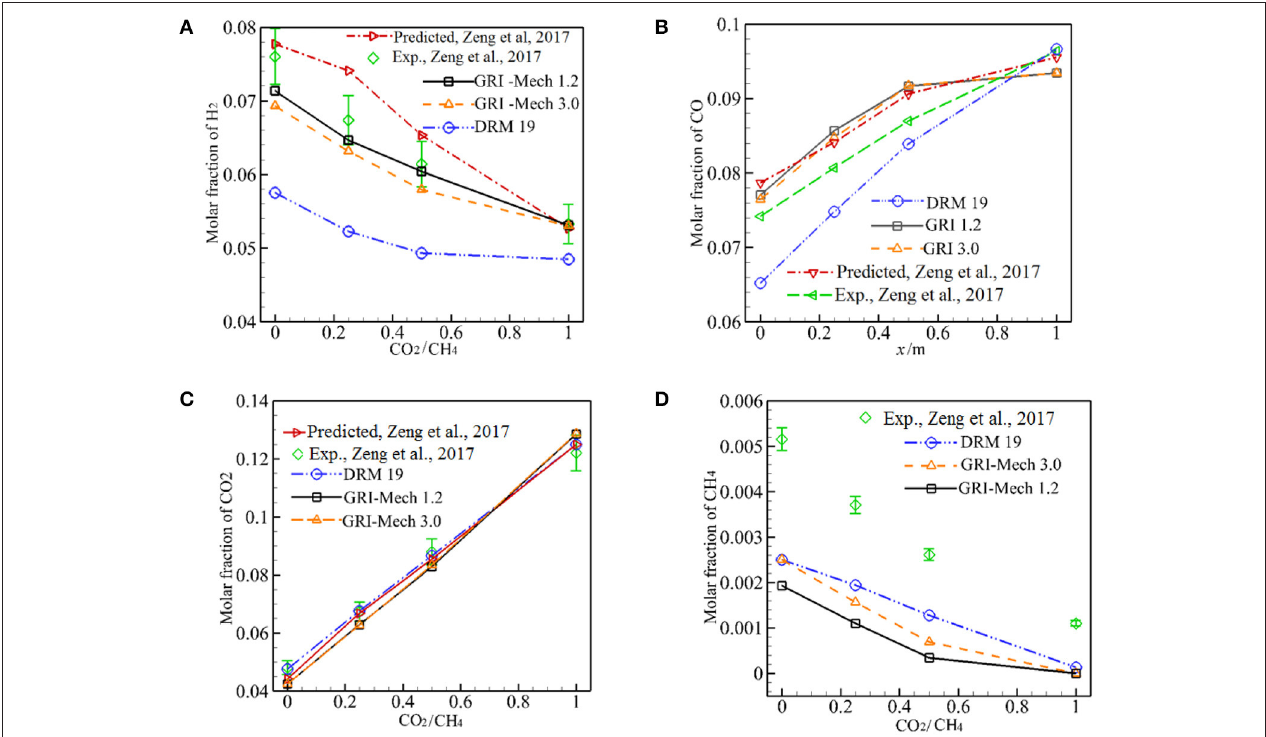
FIGURE 5 | Predicted molar fraction of H 2 , CO, CO 2 , and CH 4 by three different kinetics. (A) Molar fraction of H 2 ; (B) Molar fraction of CO; (C) Molar fraction of CO 2 ; (D) Molar fraction of CH 4